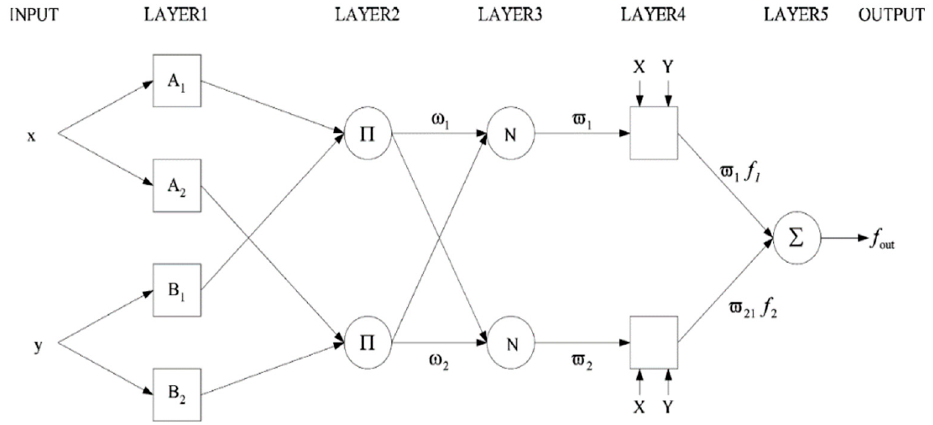
Figure 2. Example of the basic ANFIS model [50].